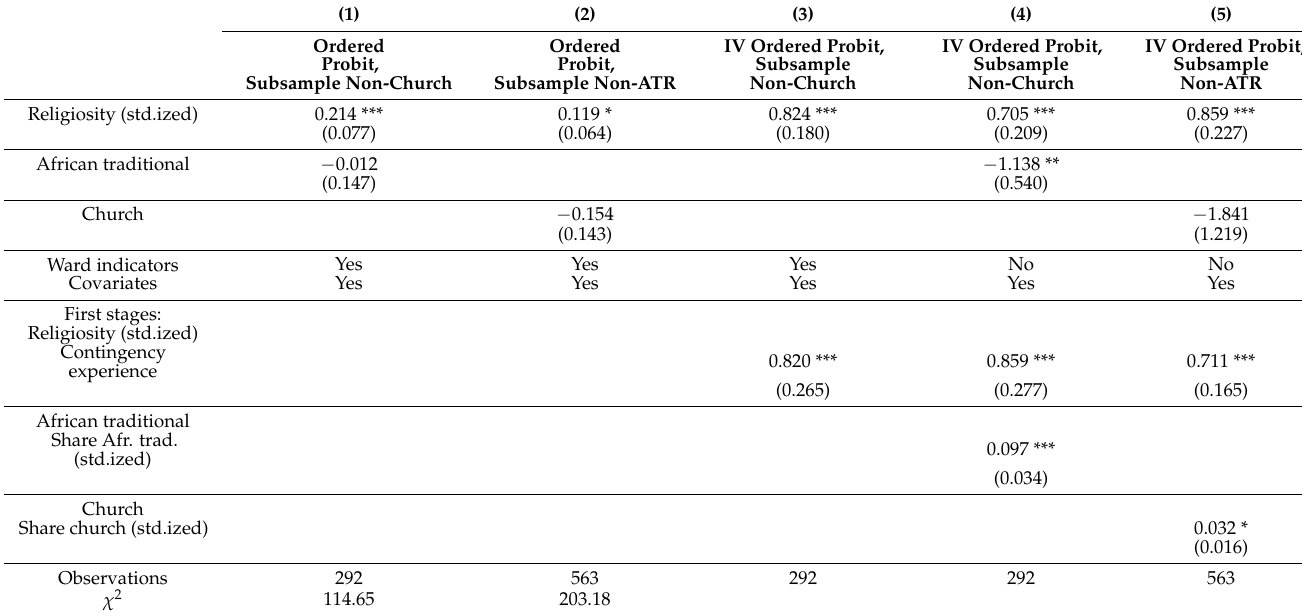
Table A6. Estimation results ordered probit model for subgroups of non-church members and non-ATR